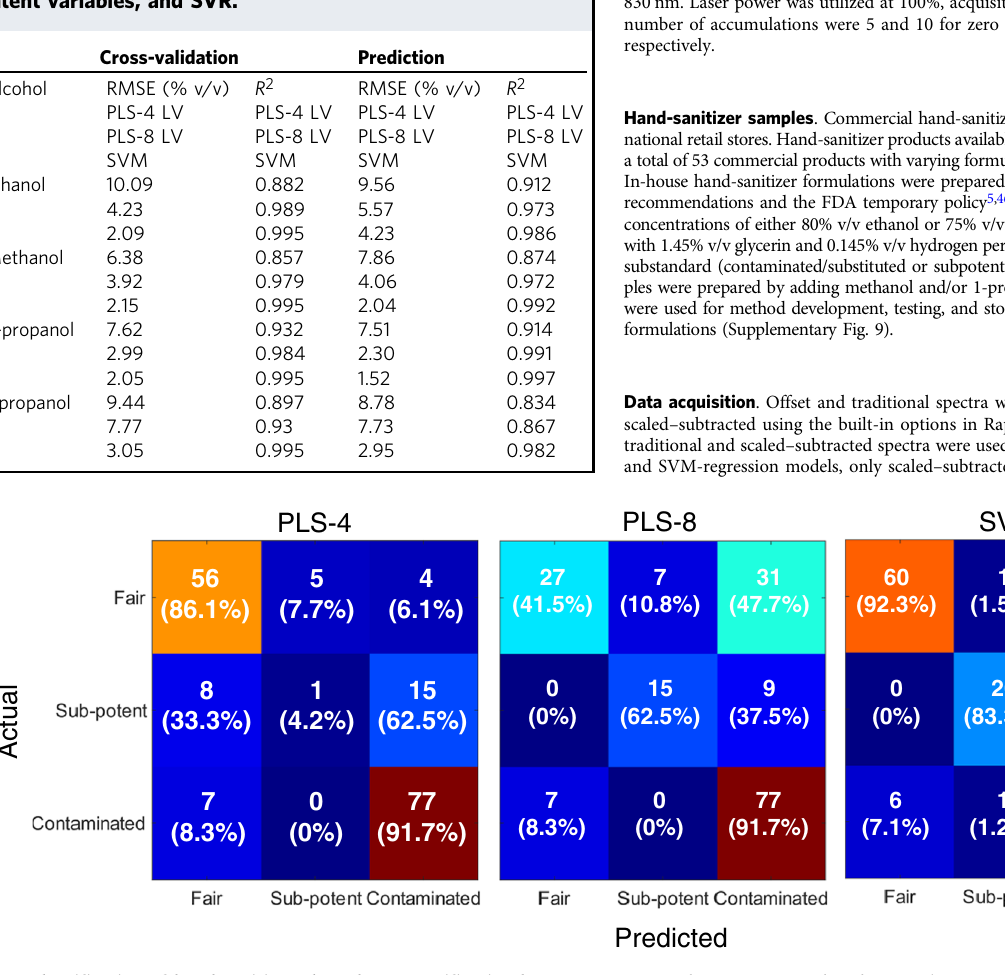
Fig. 5 Classi fi cation of hand sanitizers based on quanti fi cation by SORS – SVR. Confusion matrices for “ fair ” , “ sub-potent ” , and “ contaminated ” determinations based on PLS-4, PLS-8, and SVM models with overall accuracies of 0.77, 0.69, and 0.91.